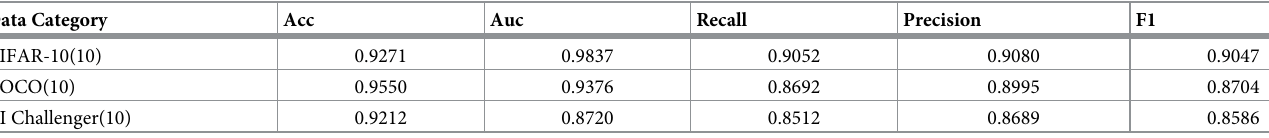
Table 4. Test performance of the research methods in this paper on three public